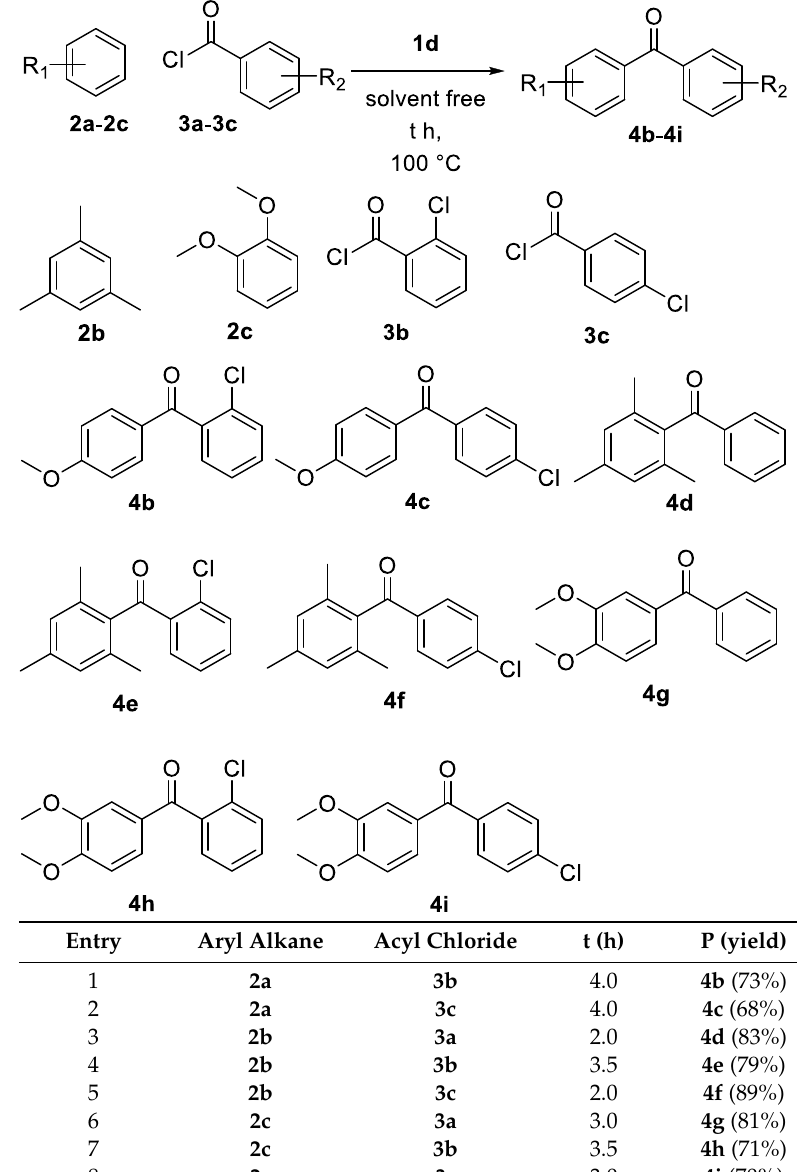
Table 2. Ionic liquids 1d catalyzed Friedel—Crafts acylation with aryl alkanes 2a – 2c and acid chlorides 3a – 3c without solvent.